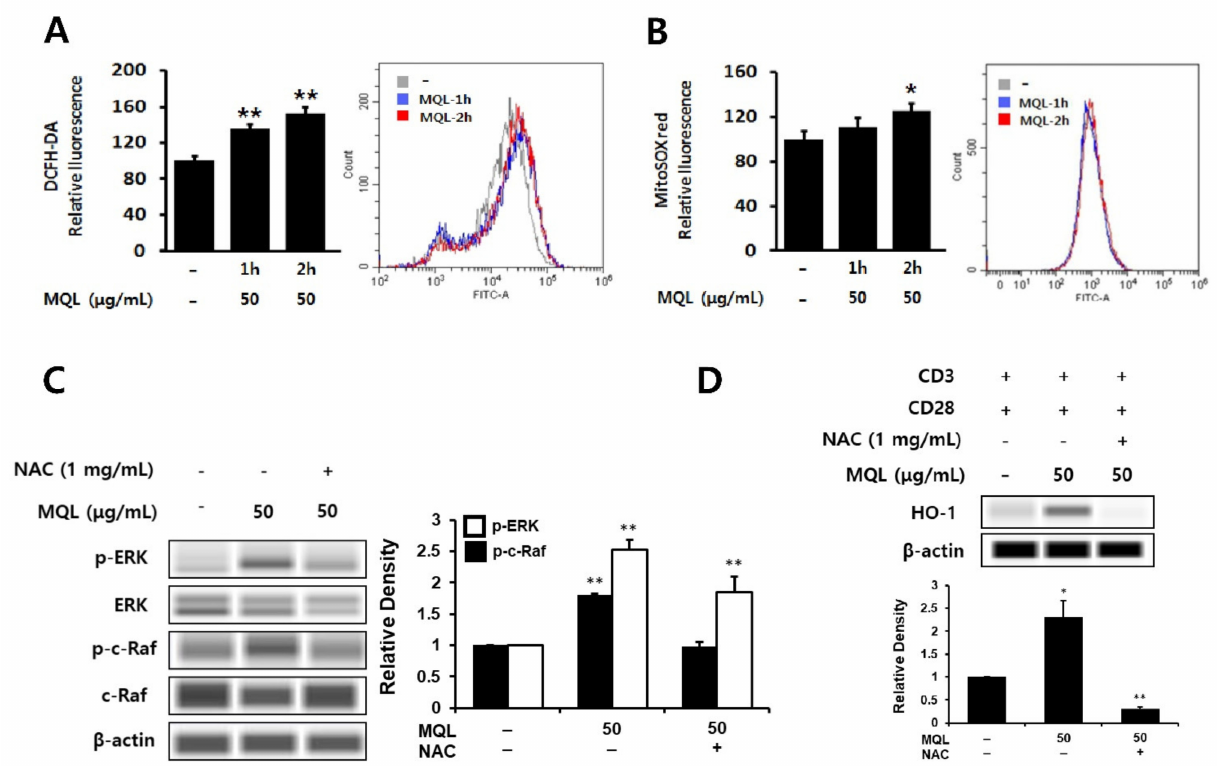
Figure 5. Effects of MQL on ROS generation in CD4 + T cells. CD4 + T cells isolated from splenocytes were cultured in the presence or absence of MQL for 2 h. Production of reactive oxygen species in CD4 + T cells was detected using ( A ) DCFH-DA and ( B ) MitoSox TM Red and measured using a fluorescence plate reader or flow cytometry. ( C ) CD4 + T cells isolated from splenocytes were pre-treated with NAC (1 mg/mL) for 1 h, then cultured for 2 h in the presence of MQL. Phosphorylation of ERK and C-Raf were detected using Western blot. ( D ) CD4 + T cells were cultured with anti-CD3 (1 µ g/mL) and anti-CD28 antibodies (1 µ g/mL) for 24 h in the presence of NAC (1 mg/mL) and MQL. HO-1 expression in CD4 + T cells was detected using Western blot. Results are shown as mean ± SD. * p < 0.05, ** p < 0.01, between the MQL-treated and non-treated